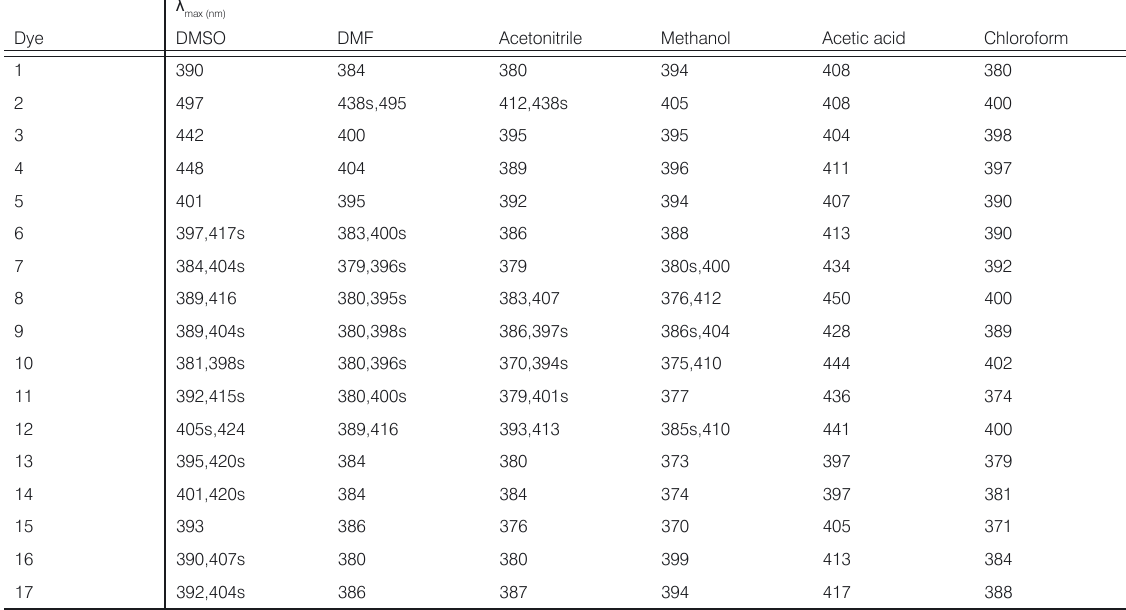
of dyes ( 1-17 max (nm)